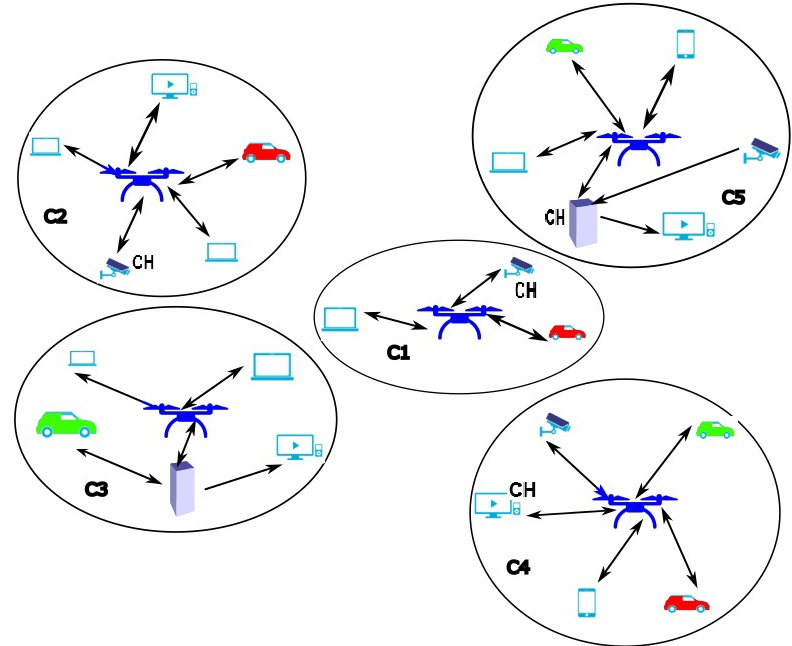
Figure 1. Model Architecture of an UAV–IoT Collaborative